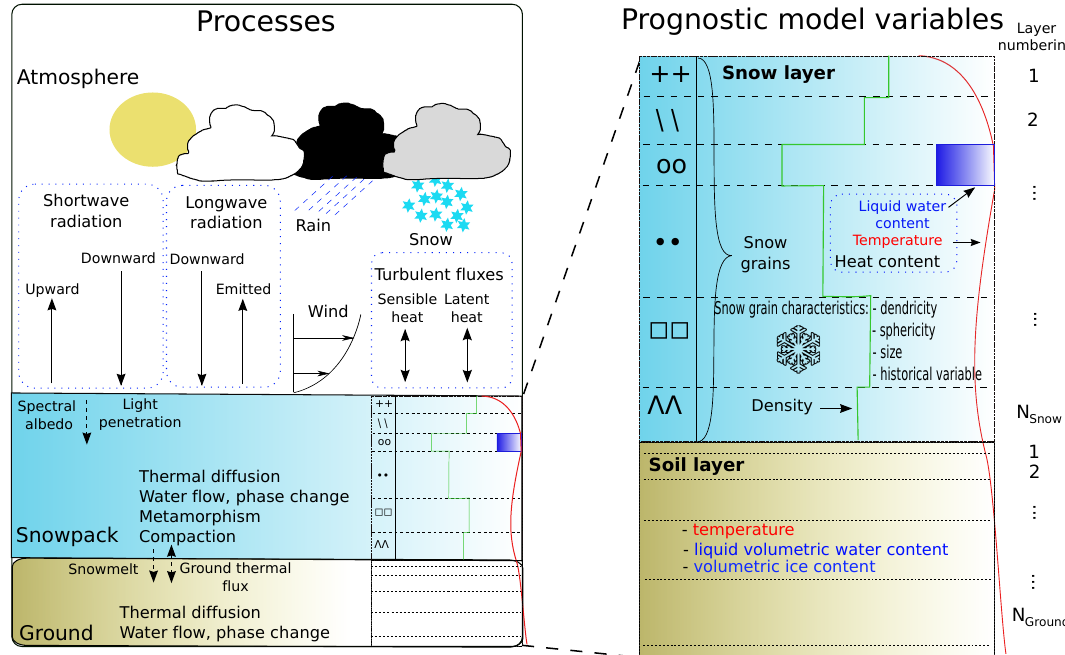
Fig. 1. Main physical processes and model